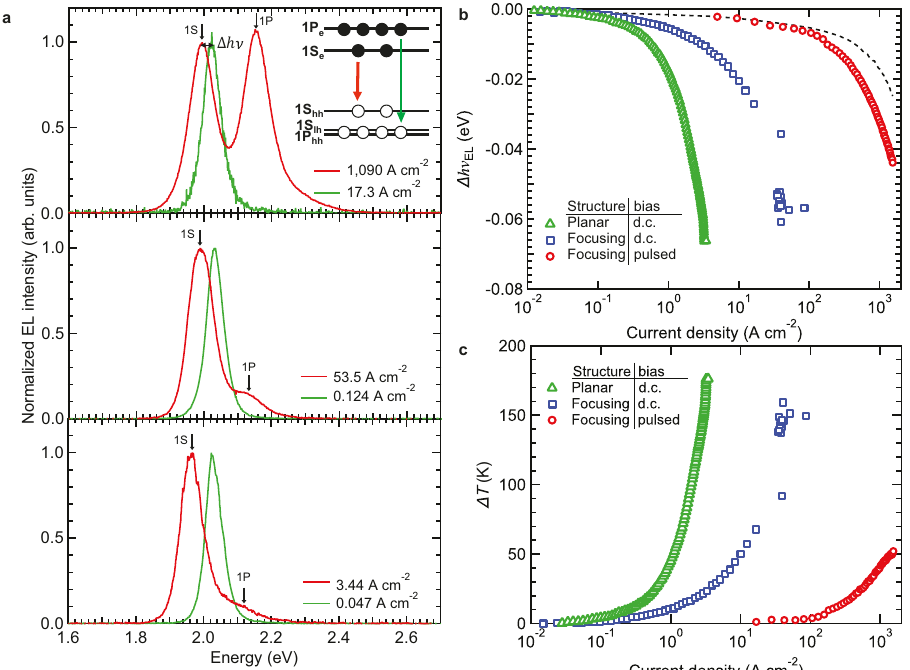
Fig. 2 Effects of current focusing and d.c.-versus-pulsed excitation on EL spectra. a 1S-peak-normalized EL spectra at low (green) and high (red) current densities for the ‘ planar ’ LED (bottom, d.c. bias) versus the current-focusing device driven by a d.c. (middle) or a pulsed (top, τ p = 1 μ s and f p = 100 Hz) bias. For all types of LEDs, the active region contains two cg-QD layers. The redshift of the band-edge 1S band ( Δ h ν ) is due to a combination of a Stark effect and Joule heating that prevail, respectively, at low and high j . Inset: Schematic illustration of optical transitions responsible for the band-edge (1S) and higher-energy (1P) EL features in the case of 6 injected excitons. Two of these excitons saturate the 1S band-edge transition and the remaining 4 are ‘ forced ’ into the higher-energy, sixfold degenerate 1P states. Subscripts hh and lh denote, respectively, heavy and light holes. The 1S lh and 1P hh levels are in close vicinity from each other; hence, higher-energy holes are able to sample both of these states. b The dependence of the shift of the 1S EL peak energy ( Δ hv EL ) on j for the ‘ planar ’ (green triangles) and ‘ current-focusing ’ (blue squares and red circles) LEDs under d.c. (green triangles and blue squares) and pulsed (red circles) biases. The initial slow redshift of the EL peak due to a Stark effect (dashed line) is followed by a rapid decrease in the emission energy due to device heating. c Device overheating ( Δ T ) as a function of j derived from the EL data in panel b (same colour coding as in b